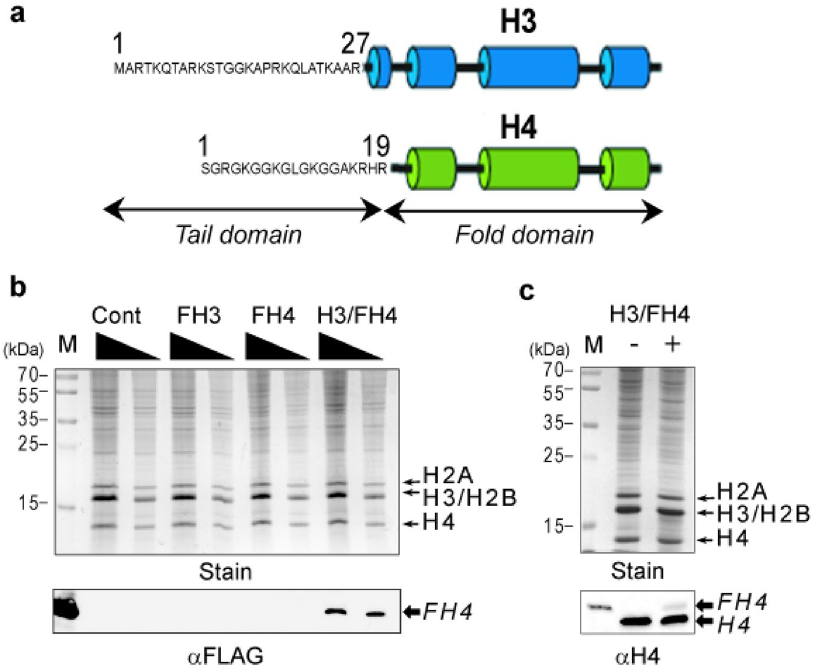
Figure 1. Folded histone complex of H3 and H4 is required for nuclear import in the S-phase. ( a ) Diagram of histones H3 and H4 illustrating the two histone domains; the N-terminal tail domain and the fold domain. ( b ) Nuclear import of exogenous histones requires the correct folding of histones. Trace amounts of purified FLAG- tagged histone H3 (FH3), FLAG-tagged H4 (FH4) and folded complex H3/FH4 (H3/FH4) were incorporated into Physarum macroplasmodium fragments in the early S-phase, using an untreated cell fragment as the control (Cont). The cell fragments were then harvested, and nuclei were isolated and analyzed by SDS-PAGE (Stain) and Western blotting with anti-FLAG antibody. Lane M corresponds to the molecular weight marker in (Stain) and the purified H3/FH4 complex revealed by anti-FLAG antibody in ( α FLAG). ( c ) Trace amount of exogenous H3/FH4 complex is incorporated into nuclei. Nuclei from cell fragments untreated ( − ) and treated with H3/FH4 ( + ) were isolated, analyzed by SDS-PAGE (Stain) and Western blotting revealed with anti-H4 antibodies ( α H4). The determination of the amount of exogenous histone relative to endogenous was determined by Western blotting with anti-H4 antibodies. Lane M corresponds to the molecular weight marker in (Stain) and the purified H3/FH4 complex revealed by anti-H4 antibodies in ( α